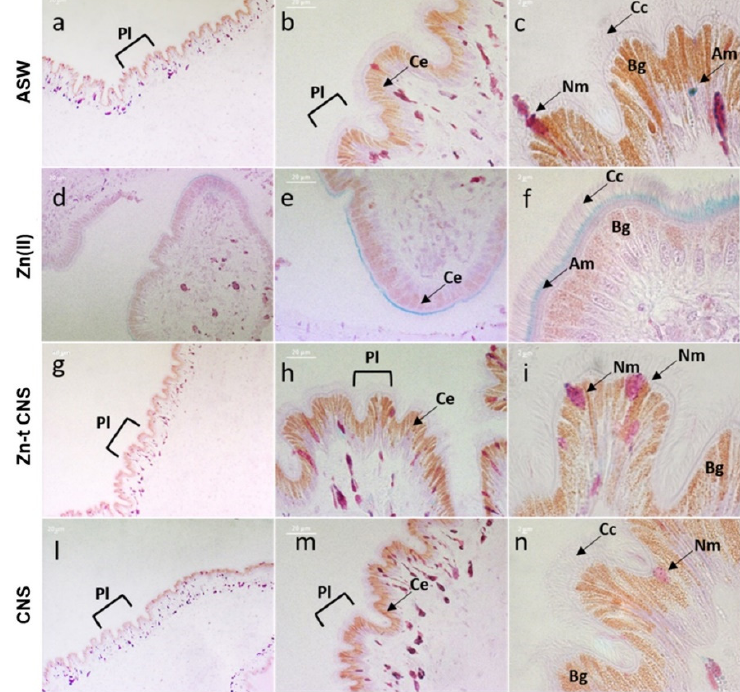
Figure 9. PAS–AB (periodic acid Schiff–Alcian blue) staining of mussels’ mantle edge cells of specimens exposed to the following experimental groups: ASW ( a , b , c , control); Zn(II) ( d , e , f , 10 mg L − 1 of ZnCl 2 in ASW); Zn-t CNS ( g , h , i , ZnCl 2 10 mg L − 1 contaminated ASW treated with CNS); CNS ( l , m , n , ASW treated with only CNS). Cc : Ciliated columnar cells; Ce : columnar epithelium; Bg : brown intracellular granules; Nm : neutral mucosubstances; Am : acidic mucosubstances; Pl : plicae. Images obtained with a Zeiss Axiophot epifluorescent microscope with AxioCamMRc5.